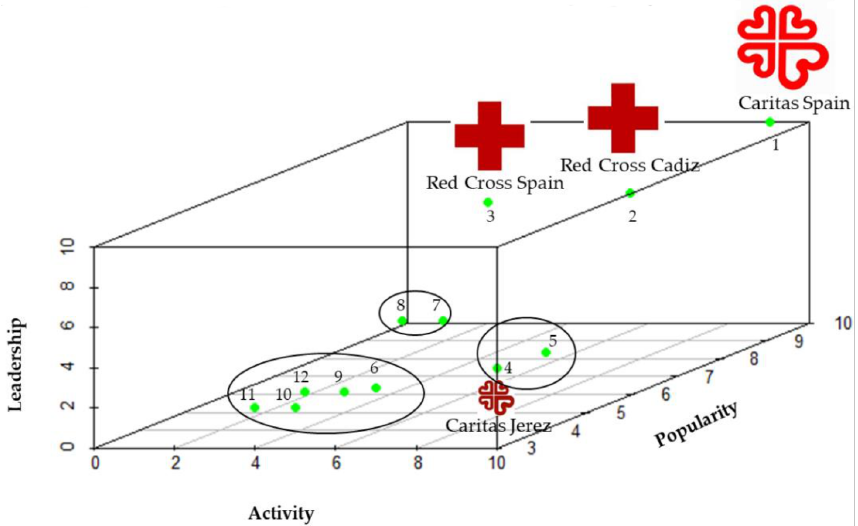
Figure 7. The positions of the organizations according to popularity, activity, and leadership